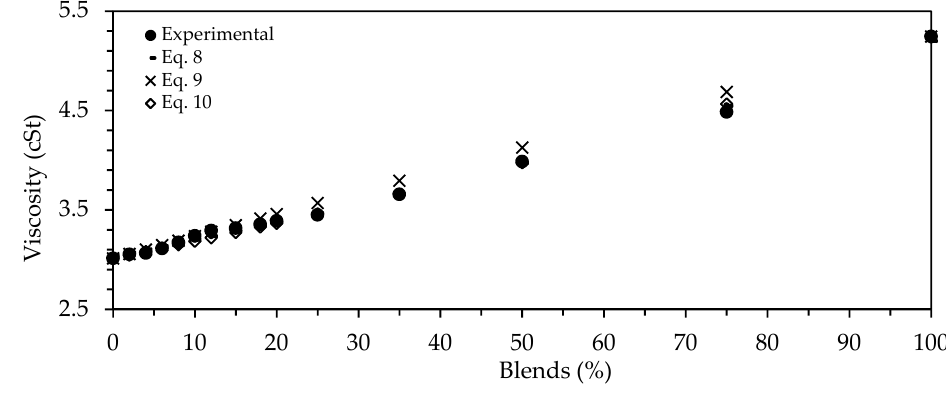
Figure 2. Viscosity variations with biodiesel content.